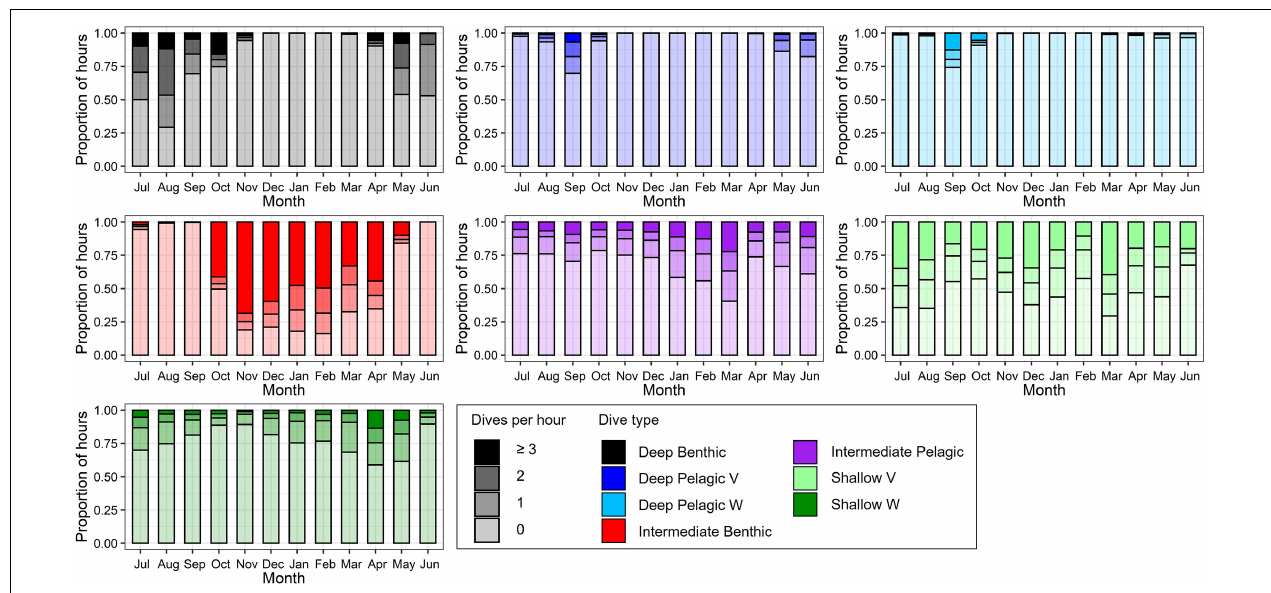
FIGURE 8 | Proportional frequency of number of each dive type per hour by month, color-coded by dive type and shaded by dive frequency. Hours with ≥ 3 dives of a given dive type combined into a single group for display.